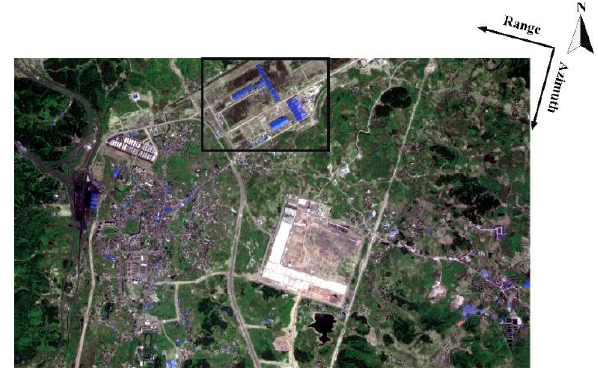
Figure 1. Optical image (Acquisition time: Jun. 2015)